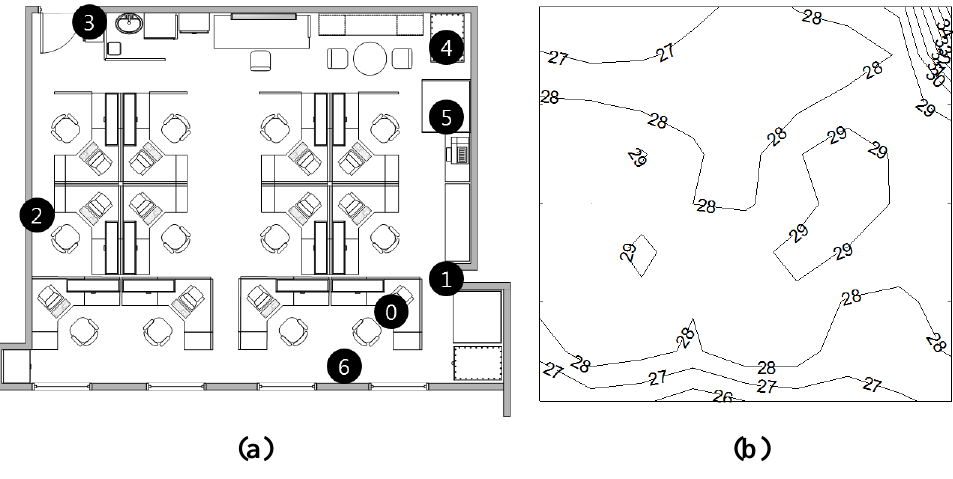
Figure 1. The layout and temperature distribution. (a) Layout; (b) Temperature distribution.